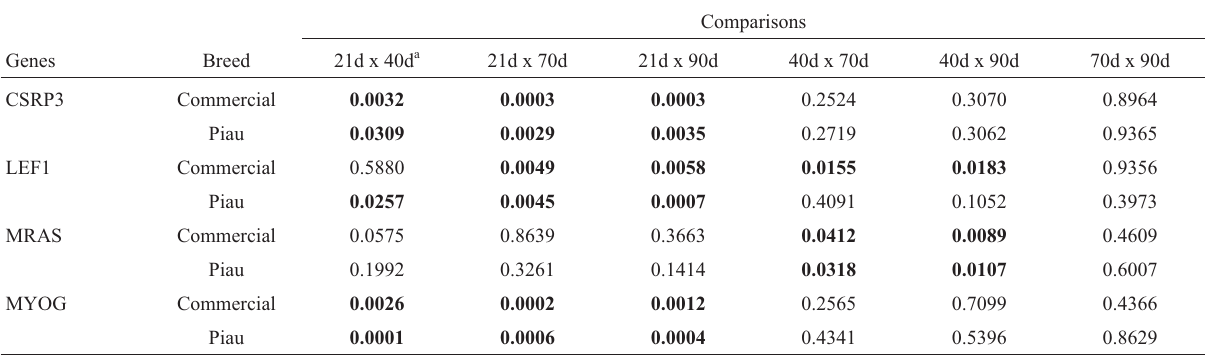
Table 5 - P-values for two-period comparisons in commercial and Piau pigs. The ANOVA results (F-test) for these genes showed a significant Breed x Period interaction.